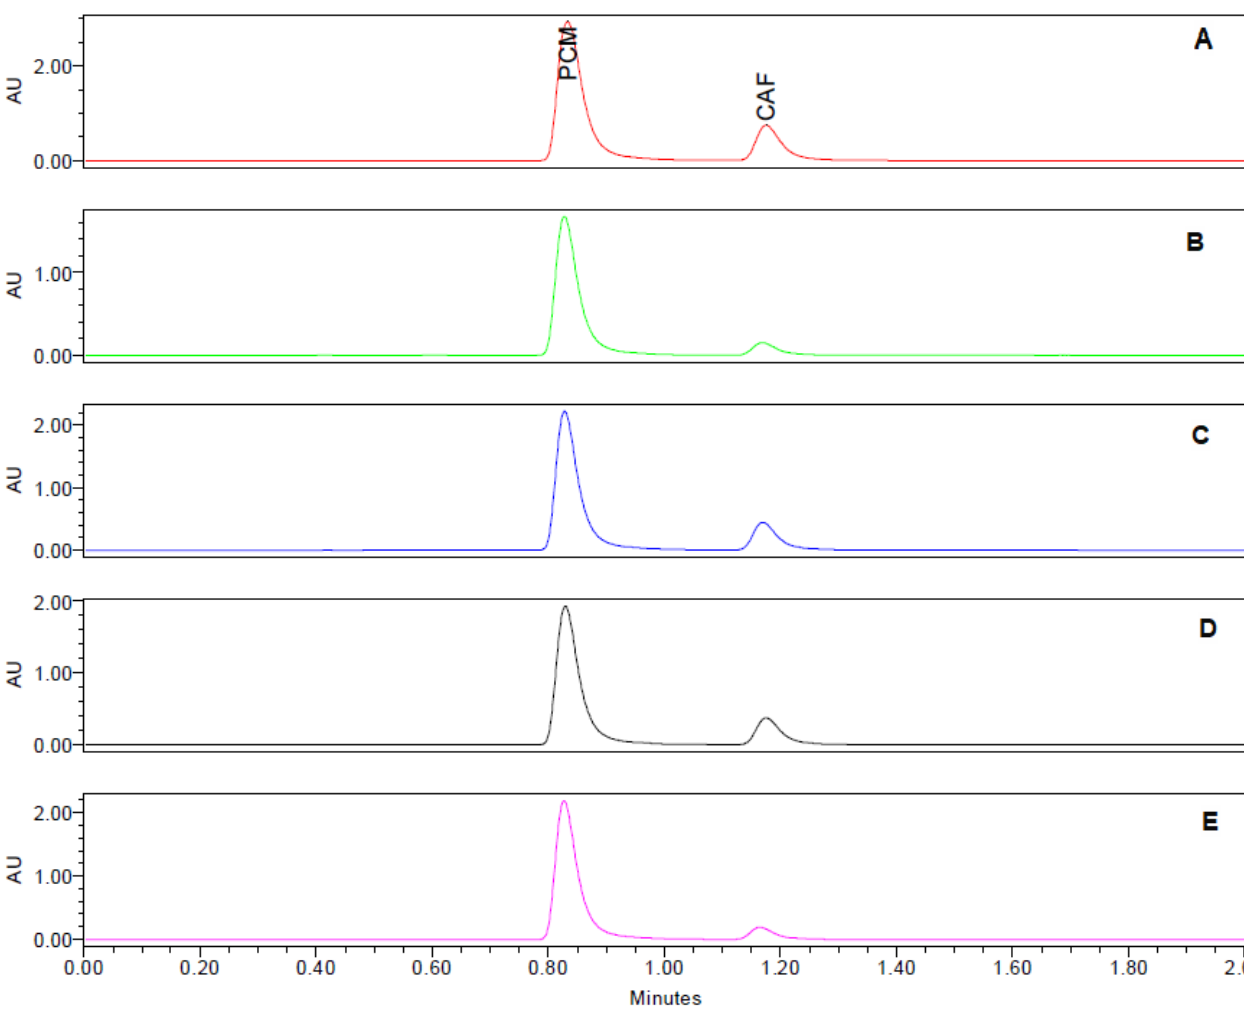
Figure 5. Stacked chromatograms of standard PCM and CAF and formulations: ( A ) standard, ( B ) Tab-1, ( C ) Tab-2, ( D ) Tab-3, ( E ) Cap-1.